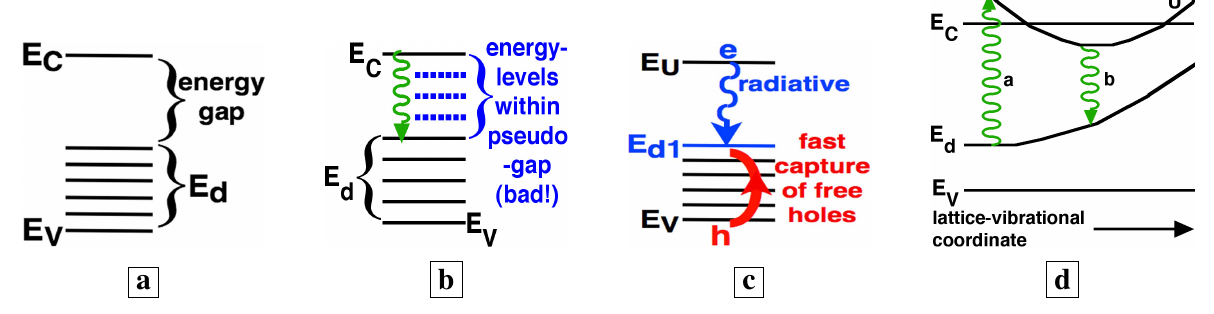
Figure 2 . a, Energies [5,6,7] associated with deep-centers in GaAs. b, The dashed lines indicate energies which lie between the upper-state (near the conduction-band) and lower-state (near midgap) of an optical transition. c, Radiative transition between a state E near the conduction-band and a deep-state E . Free holes undergo fast U d1 capture onto deep-centers. d, Energy diagram showing both the coupling to the lattice-vibrational-coordinate, and the Franck-Condon shift of absorption to higher energies than the emission.